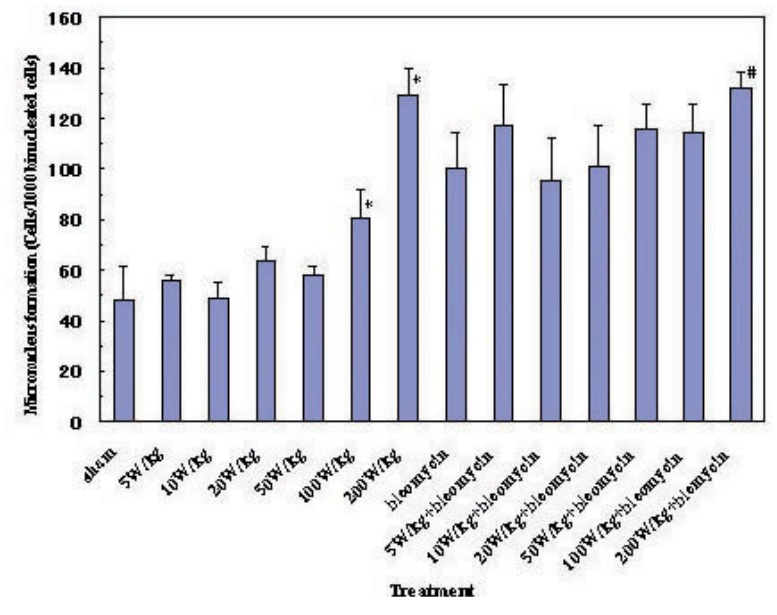
FIGURE 7 . The frequency of MN formation in CHO-K1 cells exposed to HFEMF with or without bleomycin, compared to that following sham exposure. The columns represent means and the bars show standard deviations, based on three experiments. An asterisk indicates a statistically significant difference between sham exposure and HFEMF exposure ( p < 0.01). A sharp indicates a statistically significant difference between treatment with bleomycin alone and combined treatment with HFEMF exposure and bleomycin ( p <